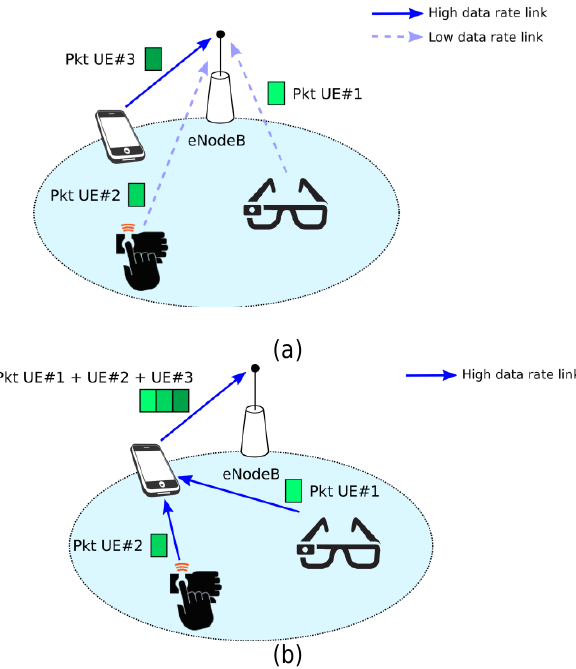
Figure 4. Differences between: (a) legacy uplink, and (b) D2D-enhanced aggregation